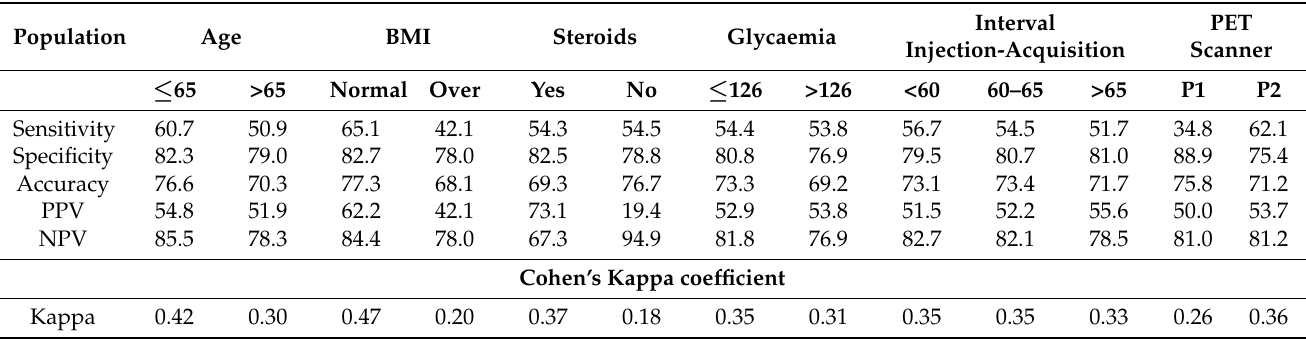
Table 3. Diagnostic performances of reader 1 detailing the values of sensitivity, specificity, accuracy, PPN, NPV, and Cohen’s Kappa overall and in each subset of patients.